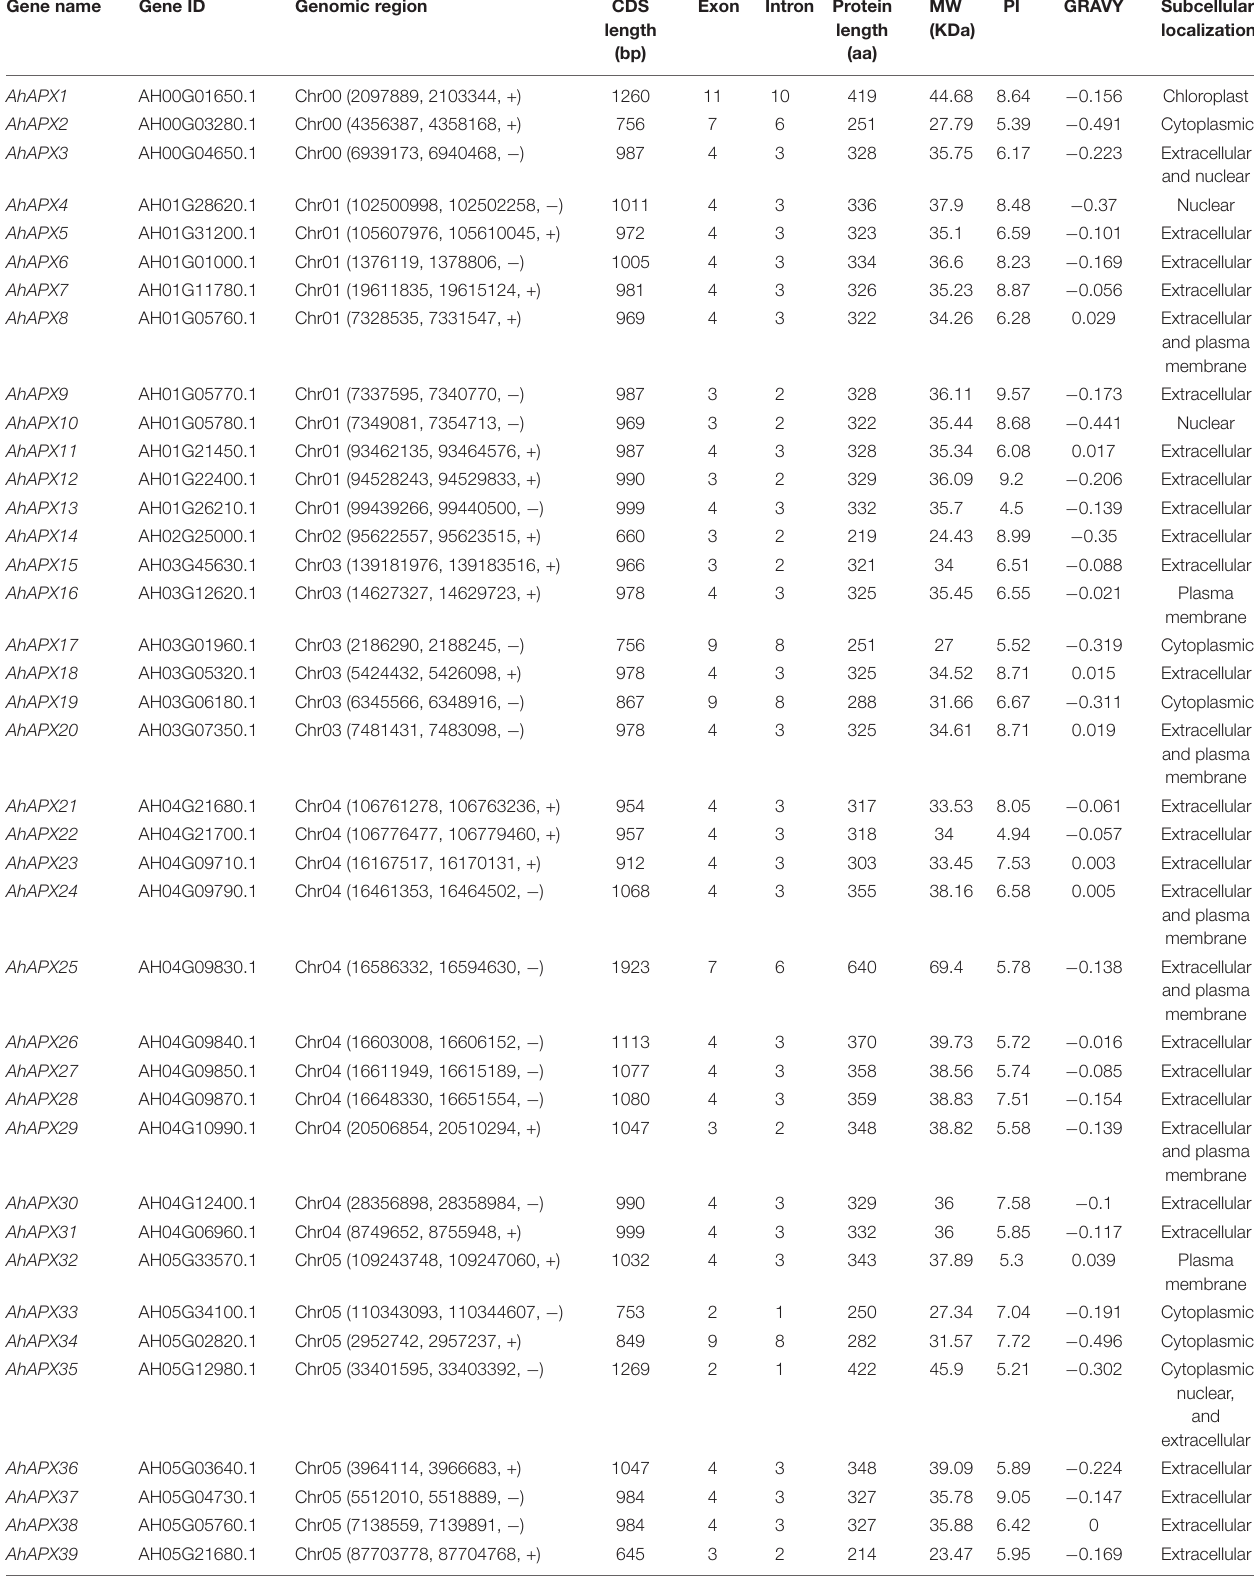
TABLE 1 | The data of 166 AhAPX genes identified in peanut